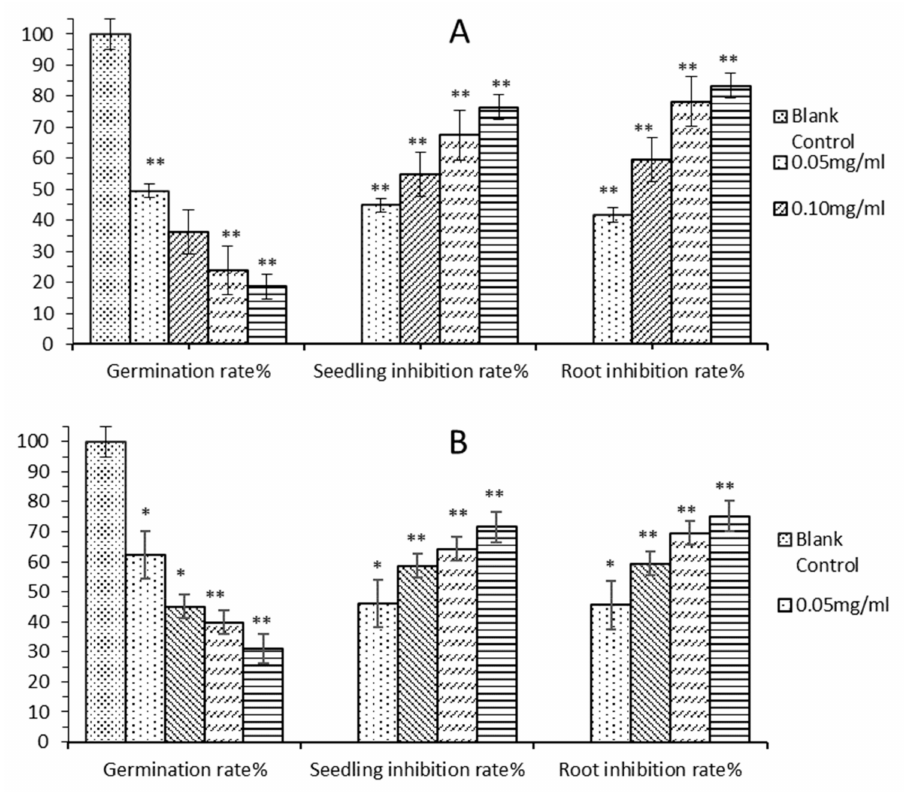
Figure 3. Allelopathic e ff ects of E. globulus leaves extract on grass seeds. (cid:8) indicates the germination rate, (cid:4) indicates the seedling inhibition rate, (cid:7) indicates the root inhibition rate, the solid line is the allelopathic e ff ect of the aqueous extracts of the E. globulus leaves on grass seeds, and the dotted line indicates the allelopathic e ff ect of the volatile components of E. globulus leaves on grass